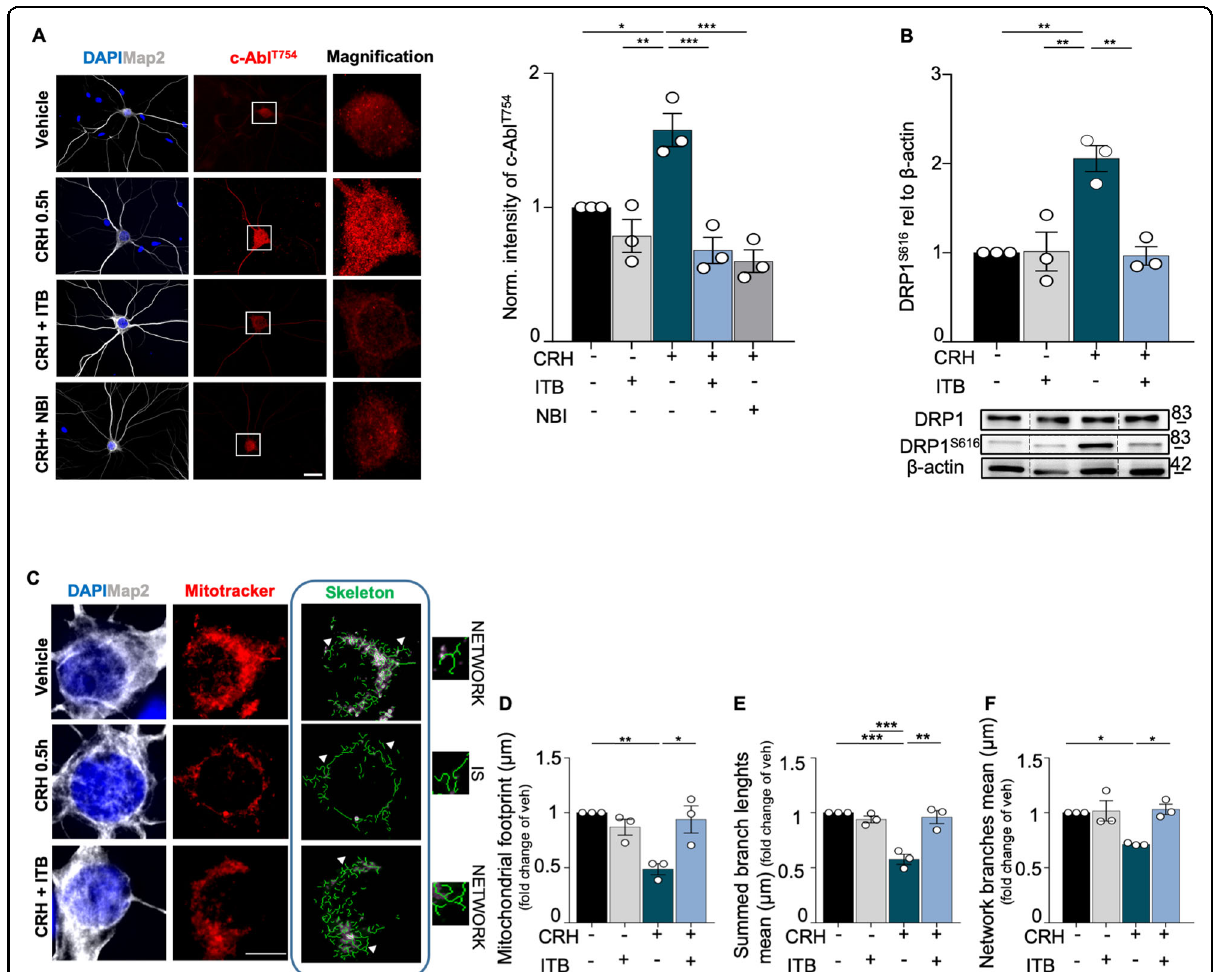
Fig. 7 CRH-dependent c-Abl activation leads to mitochondrial fi ssion, inducing mitochondrial network fragmentation. A IHC for MAP2 (gray) and c-Abl T754 (red) in primary hippocampal neurons after different experimental conditions using IMATINIB (ITB), a selective c-Abl blocker (scale bar = 30 μ m): vehicle, vehicle + ITB 3 μ M, CRH 100 nM for 0.5 h, CRH 100 nM + ITB 3 μ M and CRH 100 nM + CRHR1 Blocker NBI30775 100 nM with relative c-Abl T754 intensity analysis. Nine different neurons acquired from three different wells were analyzed for each condition in each independent experiment. B WB analysis and quanti fi cation of DRP1 S616 expression. C Somatic mitochondrial network complexity analysis after IHC, using the same experimental conditions (scale bar = 5 μ m): MAP2 (gray), mitochondria labeled with MitoTracker TM (red), mitochondrial skeletonized structures (green) (white arrows indicates examples of networks and IS) and D – F relative network parameters quanti fi cation. Somatic mitochondrial networks were analyzed in six neurons for each condition for each different independent preparation. Experiments were performed in N = 3 independent replicates at DIV14. Data are displayed as Mean ± SEM; one-way ANOVA and Bonferroni ’ s post hoc comparison test were performed; data non normally distributed were analyzed by Kruskal – Wallis non parametric test followed by Uncorrected Dunn ’ s multiple comparison test. ( *p < 0.05, **p < 0.005, ***p < 0.0005, ****p <